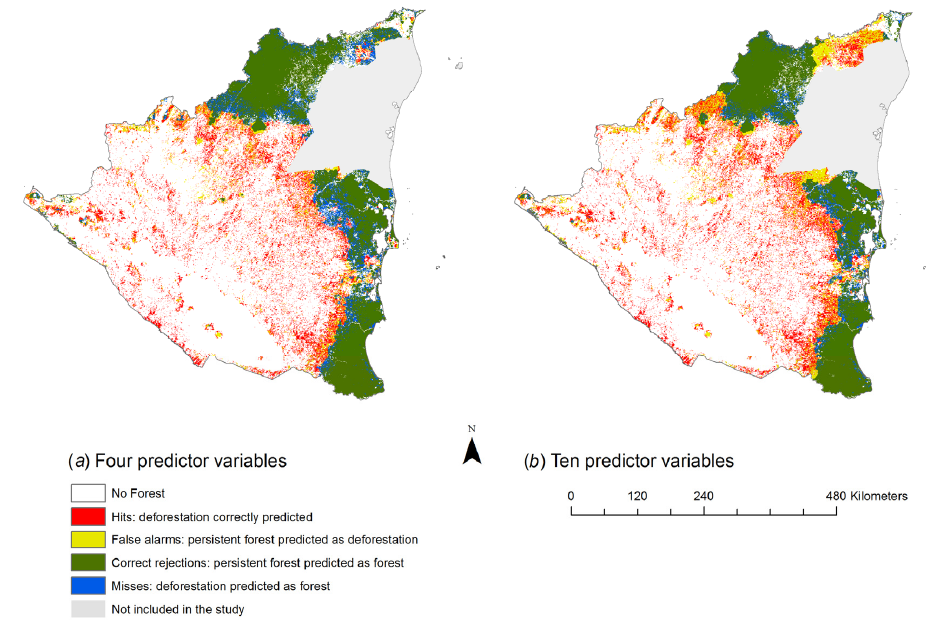
Figure 4. Distribution of agreement and disagreement for Four Predictors Alternative ( a ) and Ten Predictors Alternative ( b ), resulting from the comparison of three maps: the t2 reference map, the t3 reference map, and the t3 simulated map. Table 3. Error matrix obtained by the three-map comparison for FourPA and TenPA. Values are expressed in percentages.